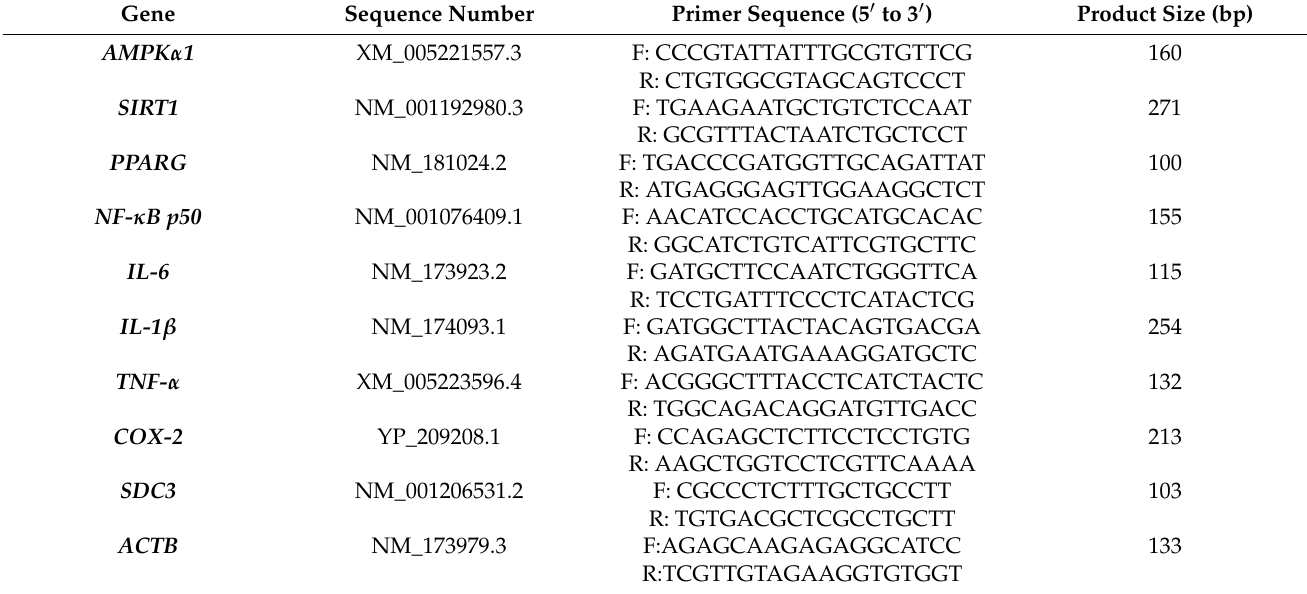
Table 1. Primer sequences used for quantitative real-time PCR 1